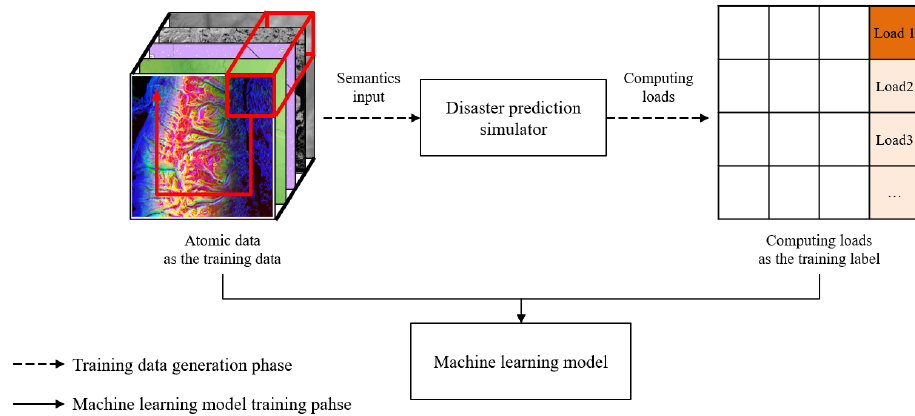
Figure 4. The supervised learning